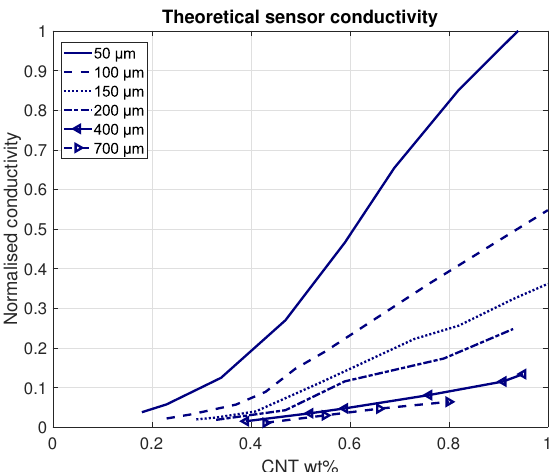
Figure 8. The theoretical conductivity for different sensors thicknesses. The thicker the layer becomes, the less sensitive the sensor.